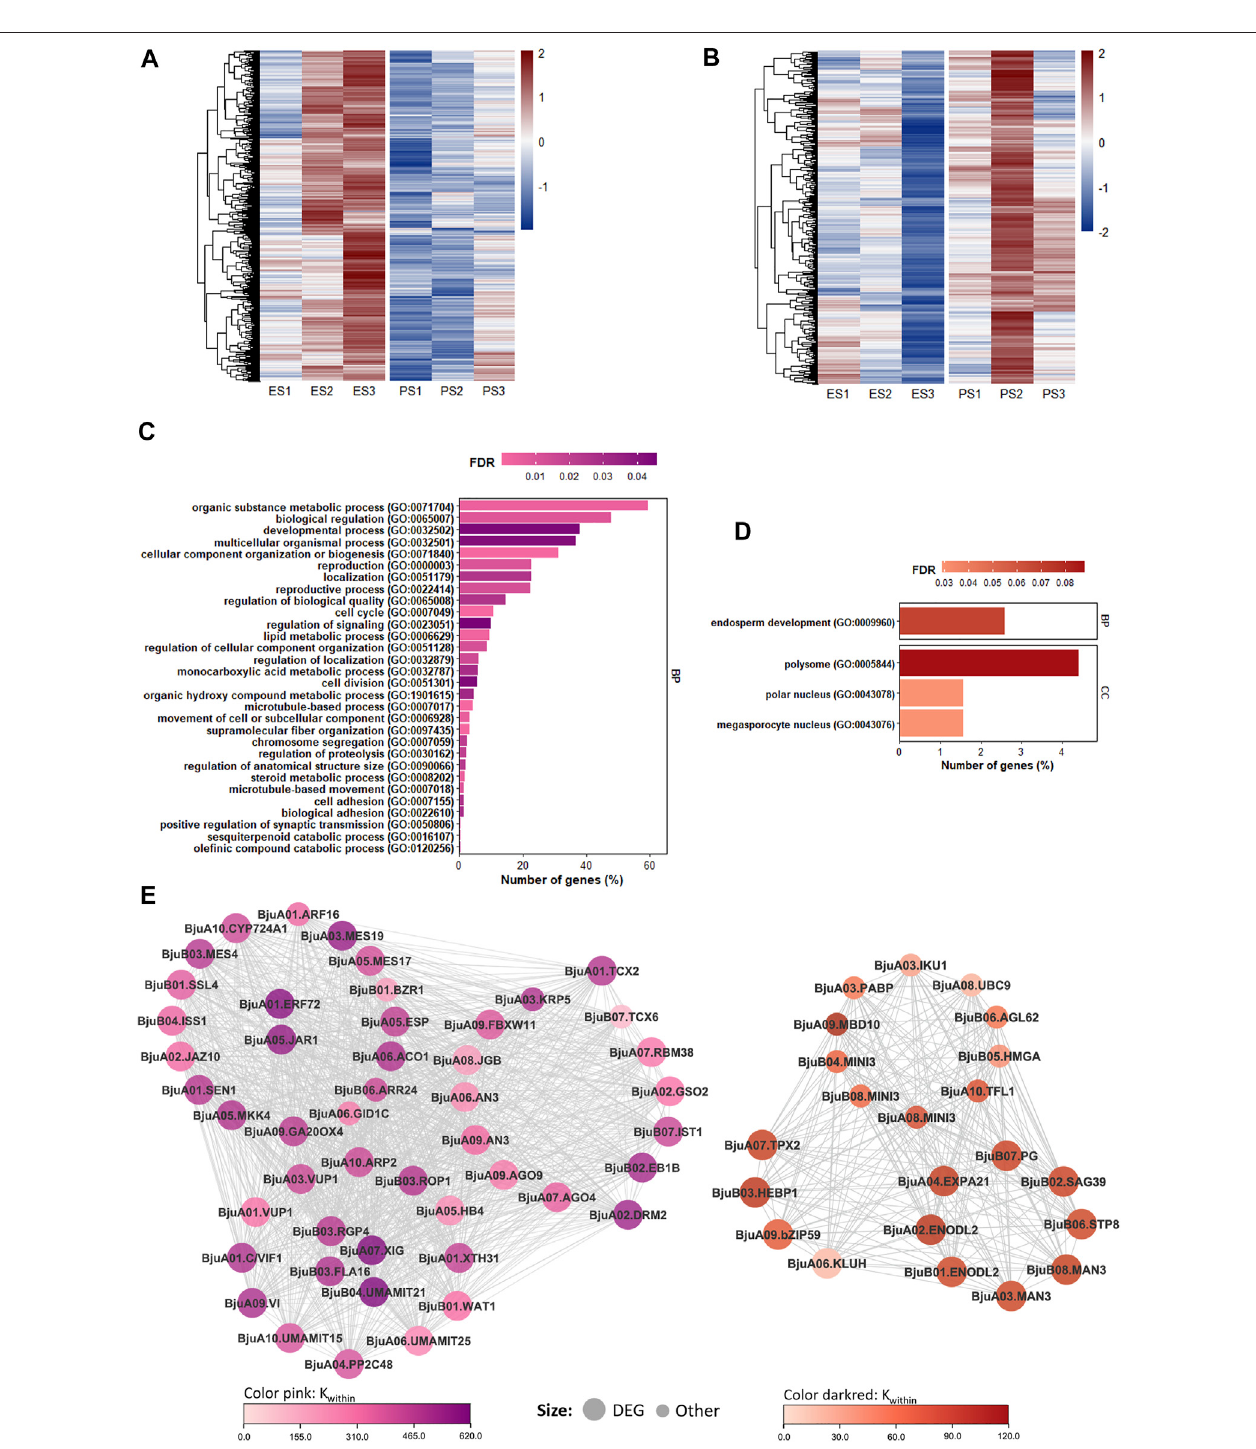
FIGURE 4 | Coexpression modules with the highest correlation with increase in seed size. (A) Heatmap showing expression pro fi les of the pink module. The color scale on the right represents Z-scores. (B) Heatmap showing expression pro fi les of the darkred module. The color scale on the right represents Z-scores. (C) GO enrichment(top 30biological process enriched terms) of thepink module. (D) GOenrichmentofthe darkred module. (E) Sub-networks connectinggenes related tocell cycle and cell division in the pink module and endosperm development in the darkred module to hub genes in EPJ Tsw QTL. E, EH-2; P, PJ; S1 – S3, seed development stages; GO, Gene Ontology; Tsw, thousand seed weight.